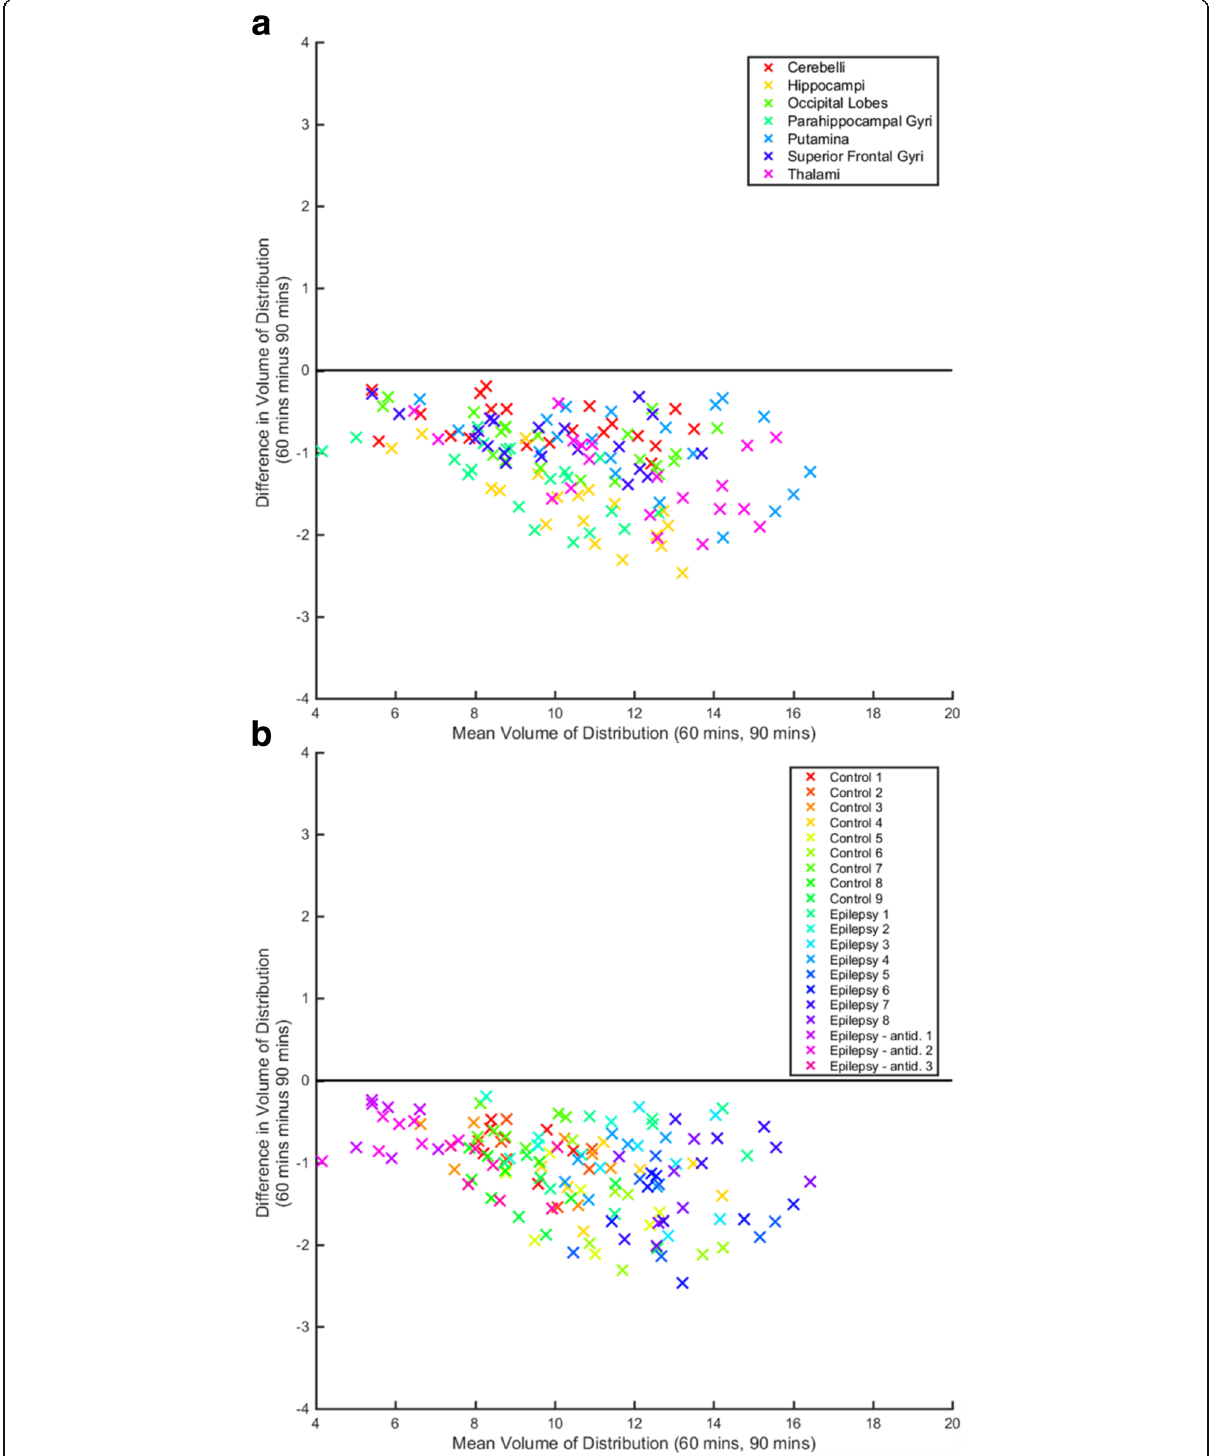
Fig. 4 Bland – Altman plot for 60 min ’ original ppIF-derived V T versus 90 min ’ original ppIF-derived V T . The colour scale depicts ROI ( a , top) or participant identification ( b , bottom). antid., antidepressants; mins,